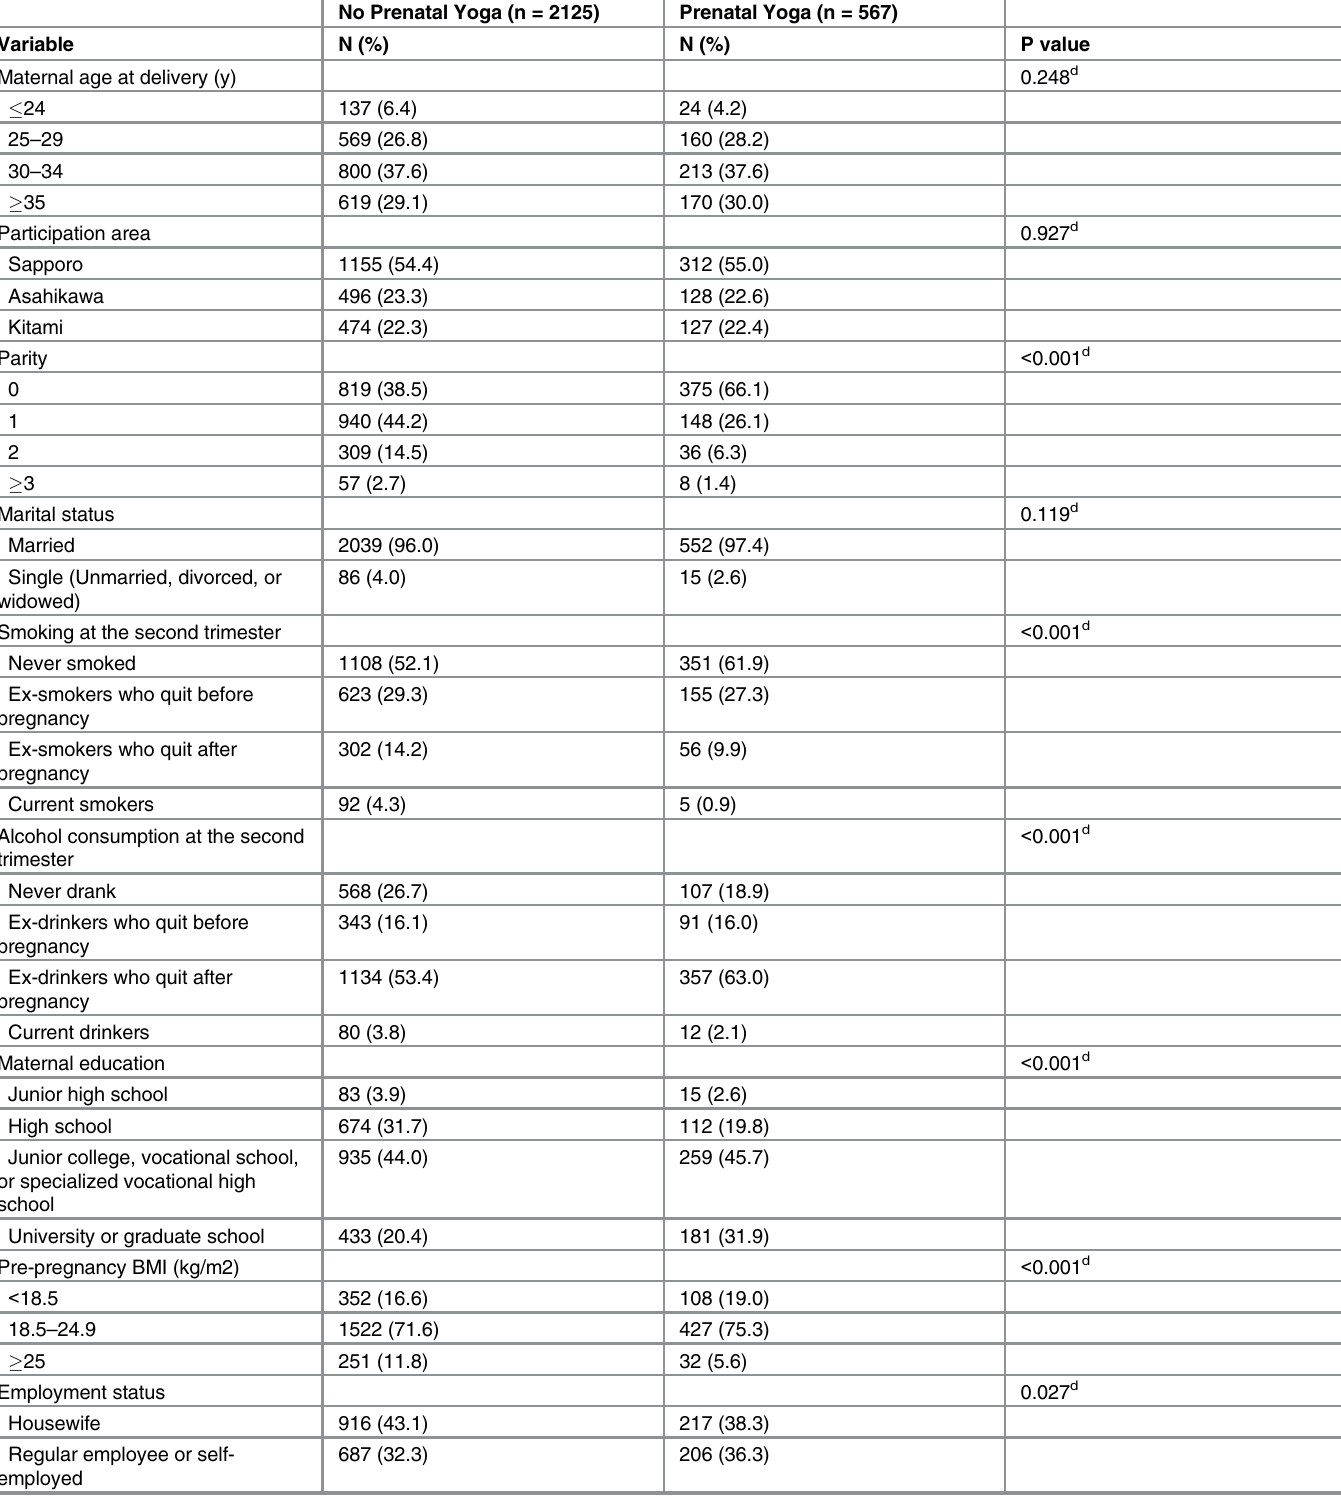
Table 1. Baseline characteristics of study participants according to practice and non-practice of prenatal